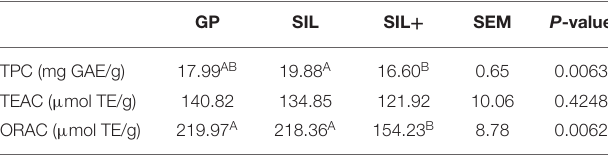
TABLE 4 | Total phenol content (TPC) and antioxidant activity (by TEAC and ORAC assays) in grape pomace (GP), and after silage with (SIL + ) or without (SIL) L. plantarum 5BG (per g dry weight).